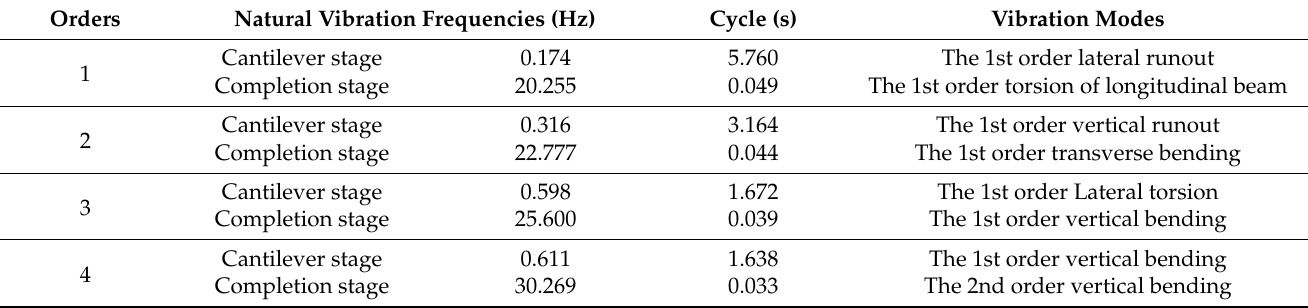
Table 2. The first ten frequencies and vibration modescharacteristics at the maximum cantilever state and completion stages.